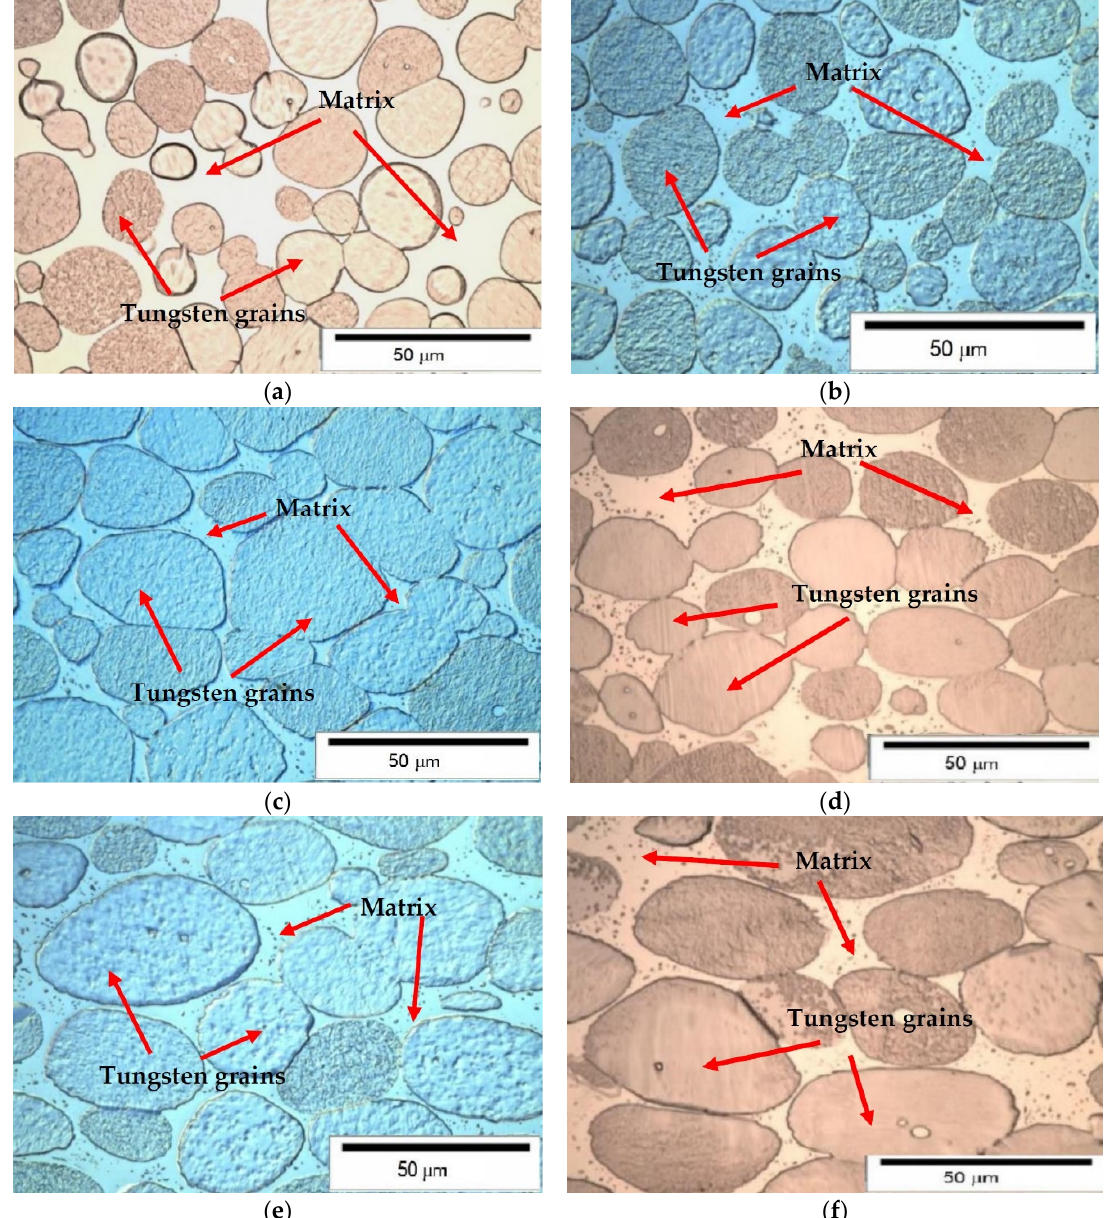
Figure 9. Microstructure of PR200 alloy after sintering ( a ), after heat treatment ( b ), and after cold swaging deformation with reduction of: 15% ( c ), 20% ( d ), 25% ( e ), and 30% ( f ).